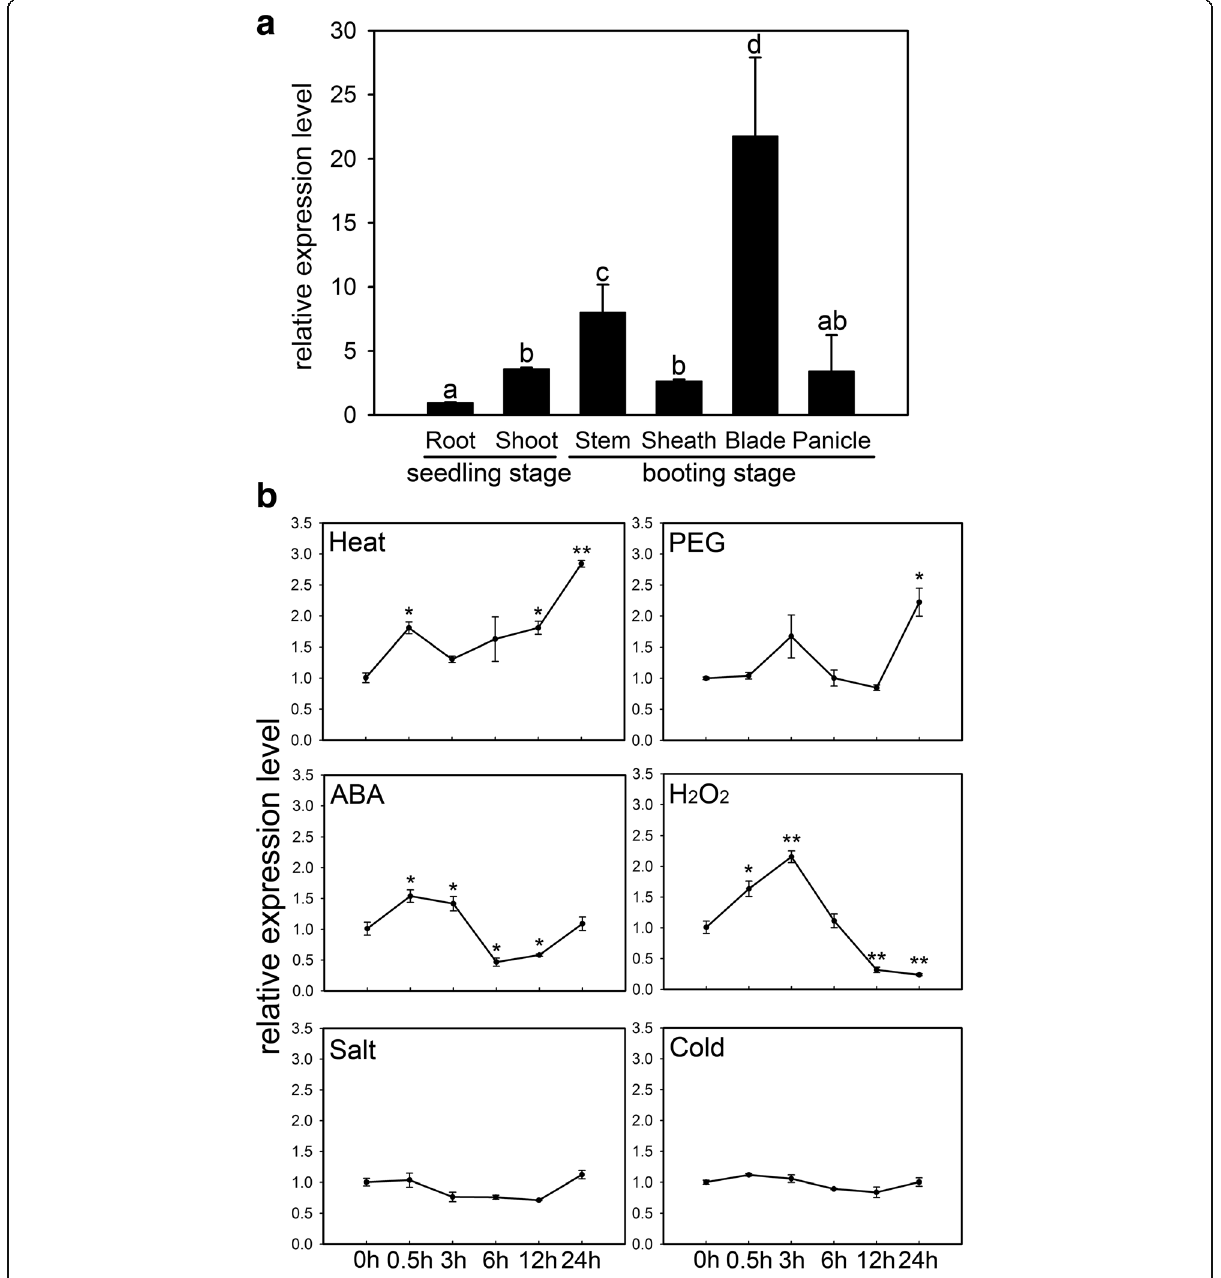
Fig. 2 Expression pattern of OsMDHAR4 . a Expression analysis of OsMDHAR4 in different tissues containing root, shoot, stem, sheath and blade of flag leaf, and panicle by qRT-PCR. Error bars indicate the SE based on three biological replicates. Statistical differences among the samples are labeled with different letters according to the LSD test ( P < 0.05, one-way ANOVA). b Expression of OsMDHAR4 under abiotic stress conditions. Seedlings (3.5- to 4.5-leaf stage) were subjected to heat (45 °C), PEG (20% [ w / v ] PEG 6000), ABA (100 μ M), H 2 O 2 (100 mM), salt (250 mM NaCl), and cold (4 °C). Relative expression levels of OsMDHAR4 were examined by qRT-PCR. The rice Actin1 gene was used as the internal control. Error bars indicate the SE based on three biological replicates. *, P < 0.05, **, P < 0.01, by Student ’ s t